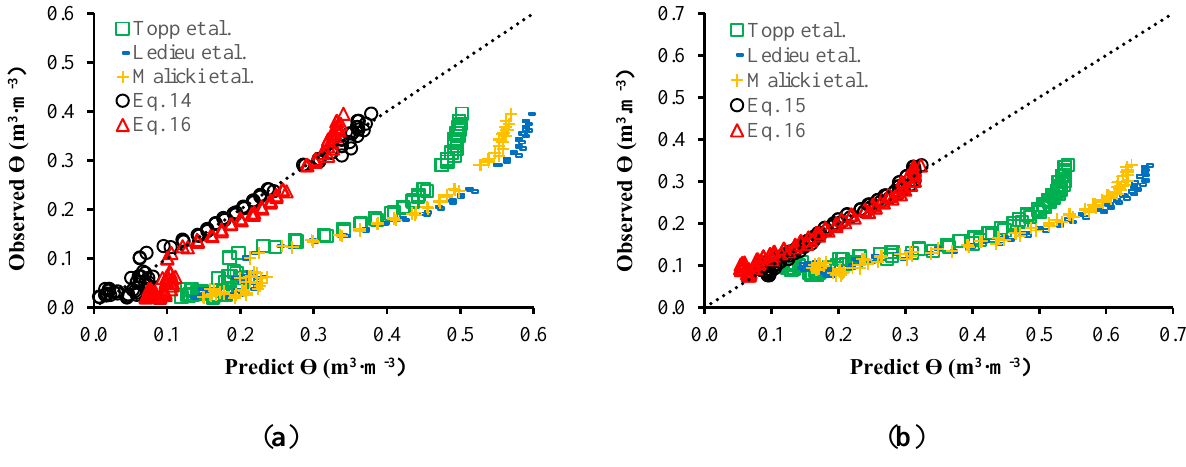
Figure 10. Relationship between predicted and observed θ for sandy ( a ) and clay soil ( b ). Table 2. Results of linear regression and cross-validation. Linear Regression